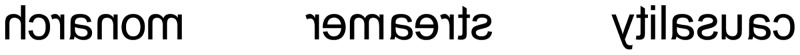
An example of a mirror-inverted triad of words.